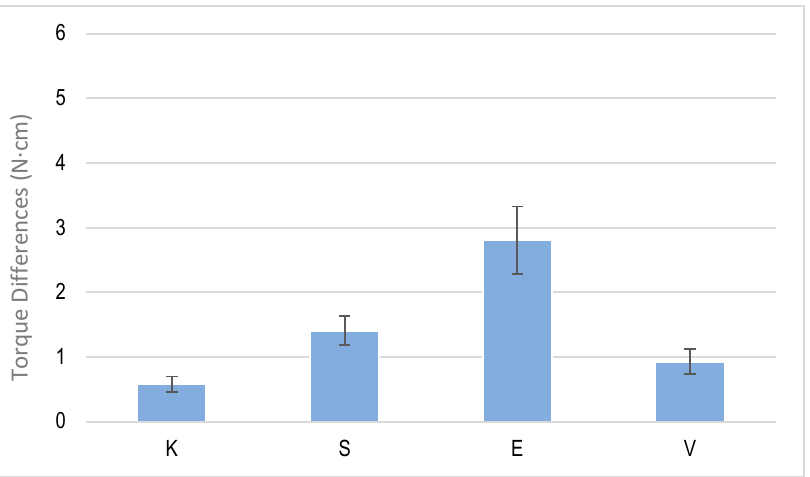
Figure 6. Torque differences for one cycle of tightening and untightening torque for each dental implant system.